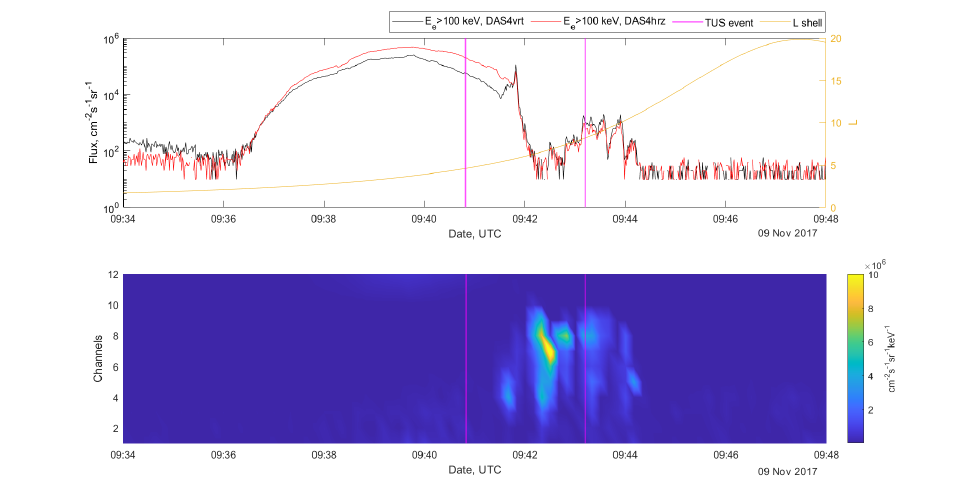
Figure 5. Comparison of TUS and METEOR-M2 data for two events measured during 9 November 2017. Upper panel : High energy ( E > 100 keV electron flux measurements by two or- thogonal detectors (vertical–vrt and horizontal–hrz). Bottom panel : plasma detector measurements, channel numbers correspond to the following mean energy: 1–0.032 keV; 2–0.065 keV; 3–0.13 keV; 4–0.26 keV; 5–0.52 keV; 6–1.04 keV; 7–2.08 keV; 8–4.16 keV; 9–8.32 keV; 10–16.64 keV. Vertical lines show TUS events position.